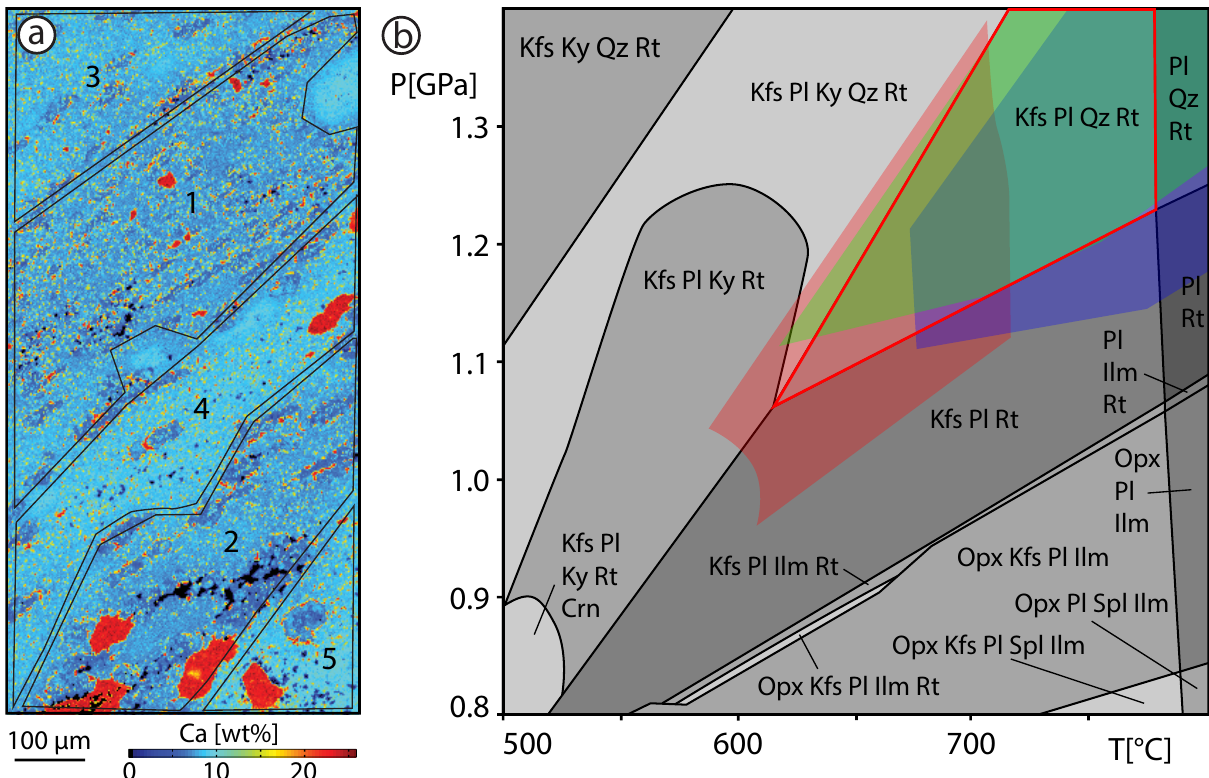
Figure 8. Quantified X-ray map for Ca for sample S5 with a step size of 2µm and 250pixel × 500pixel. Minerals visible: red: Cpx; dark blue: Grt; medium blue: low-Ca Pl; light blue: high-Ca Pl. Areas are defined by the Pl composition. (b) Pseudosection for sample S5, area 2; all parageneses also have Grt + Cpx. Overlays of the observed stability fields for parageneses from pseudosections from the other areas: red: area 1; green: area 3; blue: area 5. For the microstructural context of the area, see Fig.